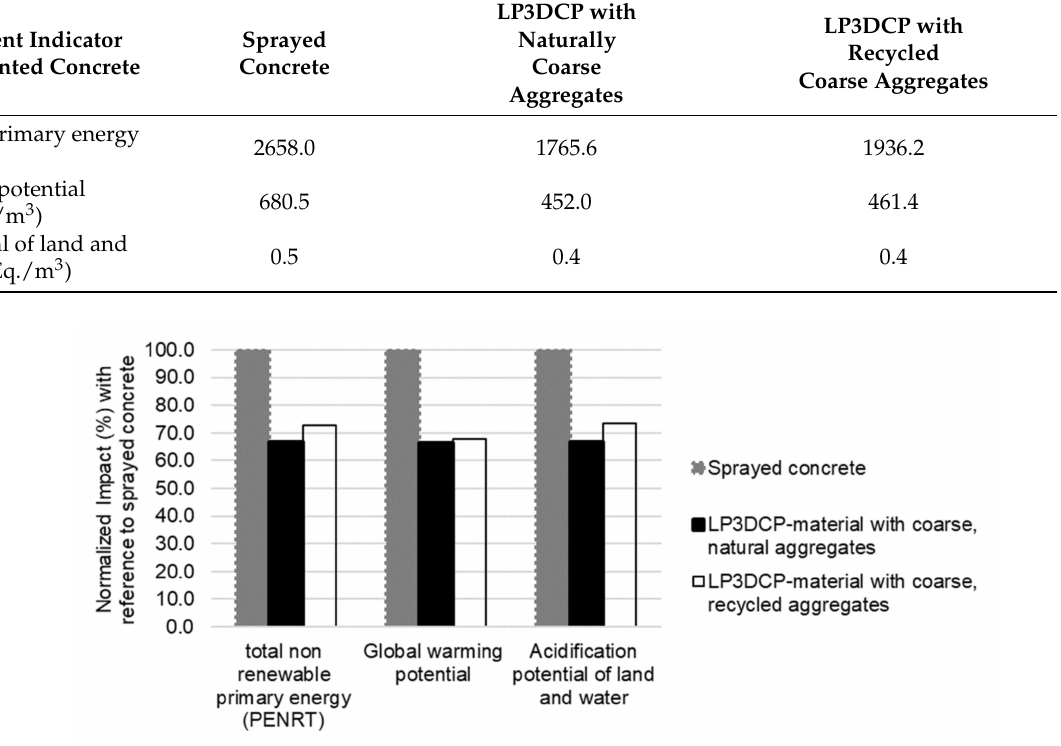
Table 3. Life cycle assessment indicators for 1m 3 of a regular 3D printing material and LP3DP.